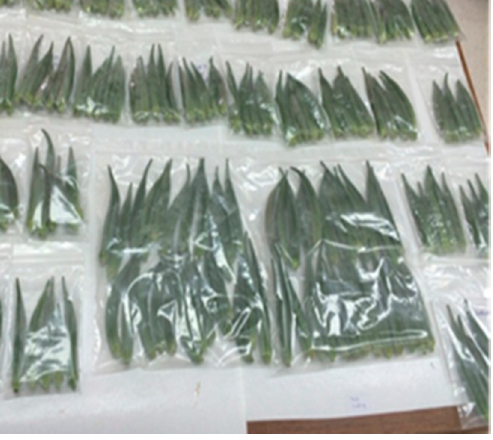
Figure 1. Photo of all the Okra samples in different polyethylene packages.